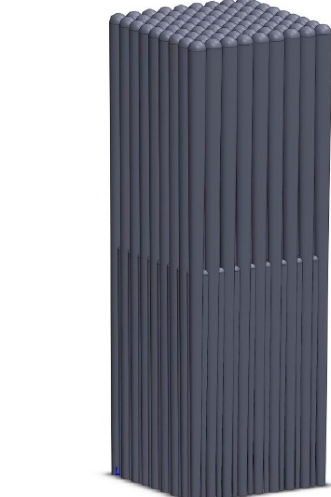
Figure 1. Scanning electron microscopy (SEM) micrograph of the electron beam physical vapor deposition (EB-PVD) coat- ings.